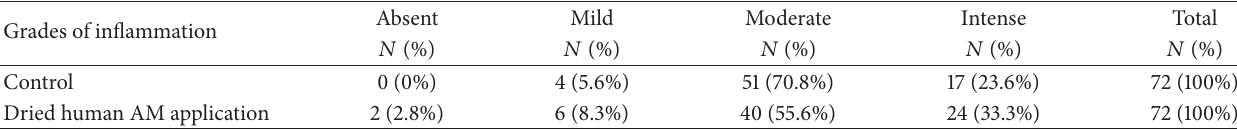
Table 1: The number of sagittal sections (6 sagittal sections per rabbit eye) with each grade of inflammation after strabismus surgery according to the treatment (dried human amniotic membrane (AM) or control). Grades of